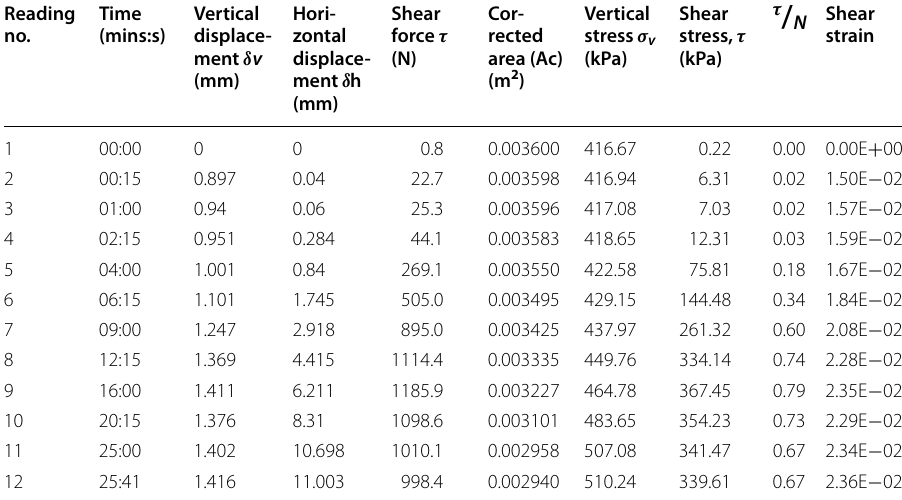
Table 5 Typical computation for test at 477 kPa normal stress for soil–concrete interface for specimen 3 set 2 Reading